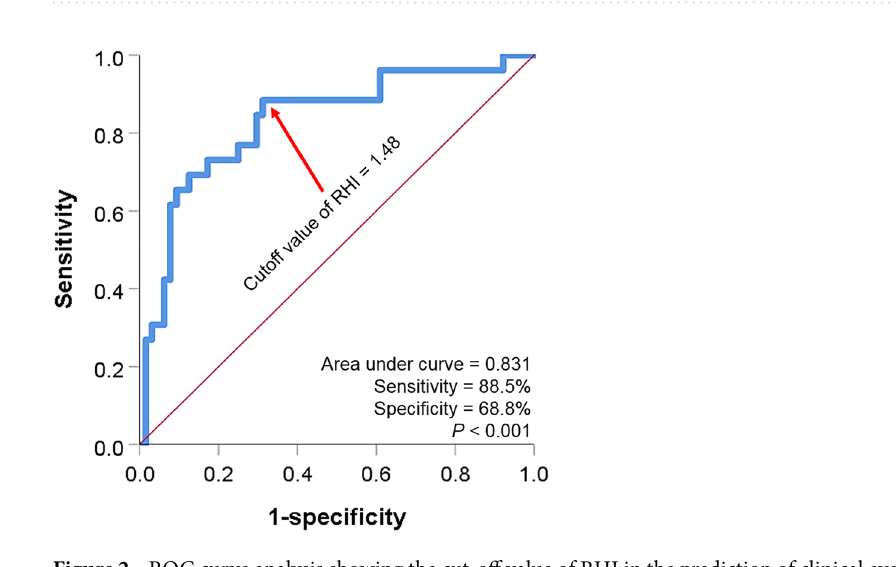
Figure 2. ROC curve analysis showing the cut-off value of RHI in the prediction of clinical events ROC, receiver operating characteristic; RHI, reactive hyperemia